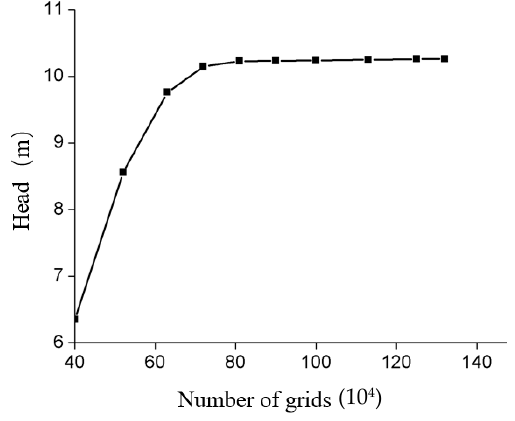
Figure 7. Grid-independent test curve.